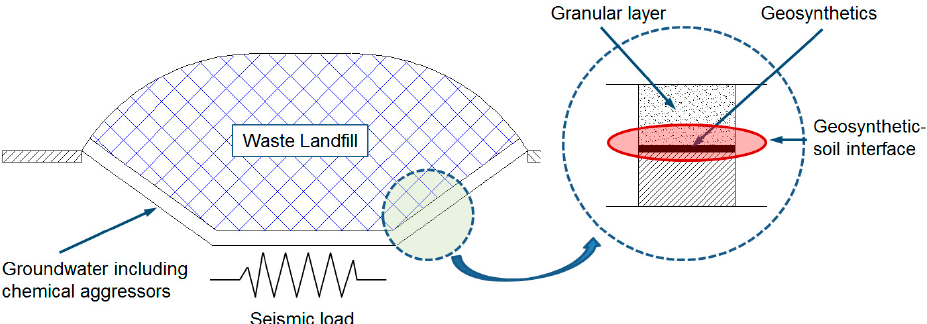
Figure 1. Section of waste landfill and concept of geosynthetic–soil interface [4].